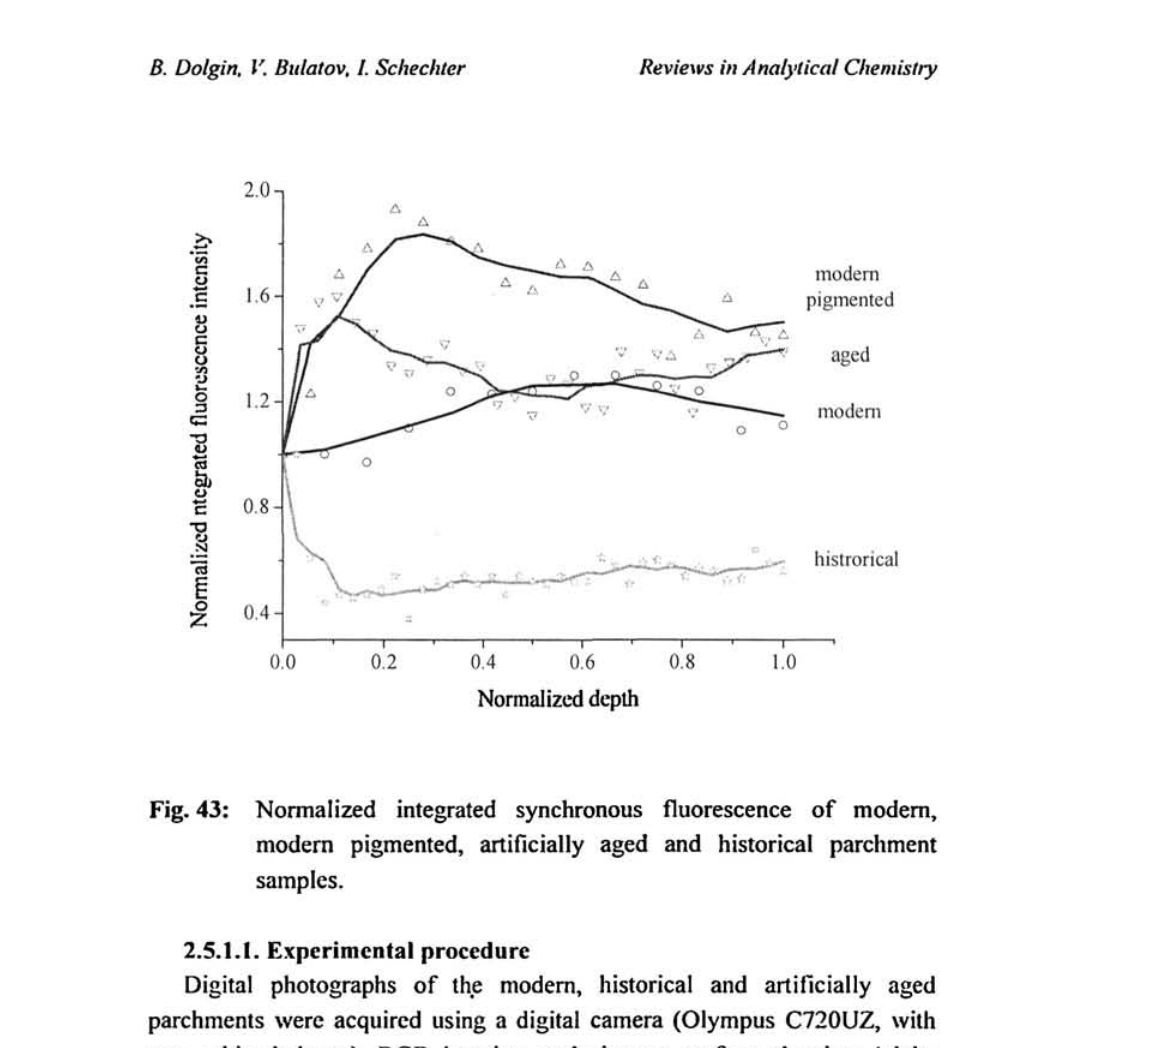
Fig. 43: Normalized integrated synchronous fluorescence of modern, modern pigmented, artificially aged and historical parchment